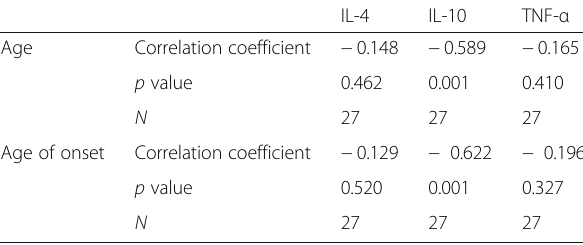
Table 3 Correlations of cytokines levels to age, age of onset, and BMI